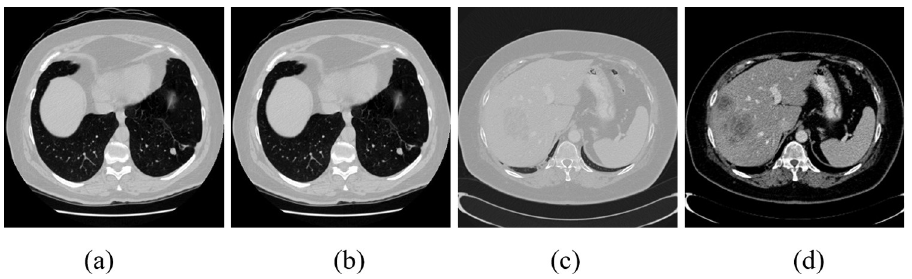
Fig 2. Samples of image after preprocessing. (a) Original image of LUNA16. (b) Fig (a) after preprocessing. (c) Original image of LiTS17. (d) Fig (c) after preprocessing.